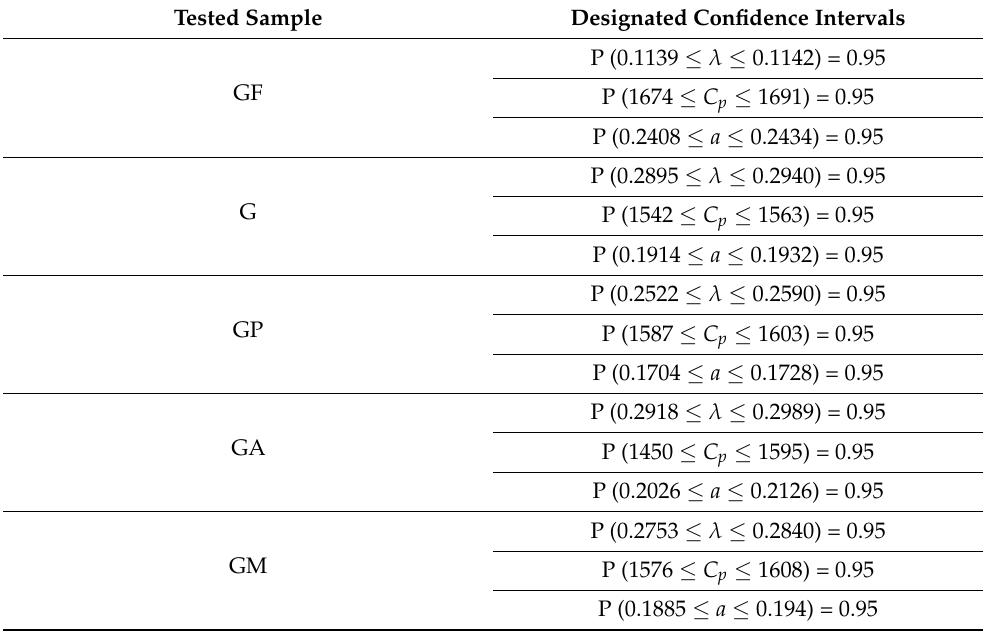
Table 4. The calculated confidence intervals of the measured thermal properties of the building